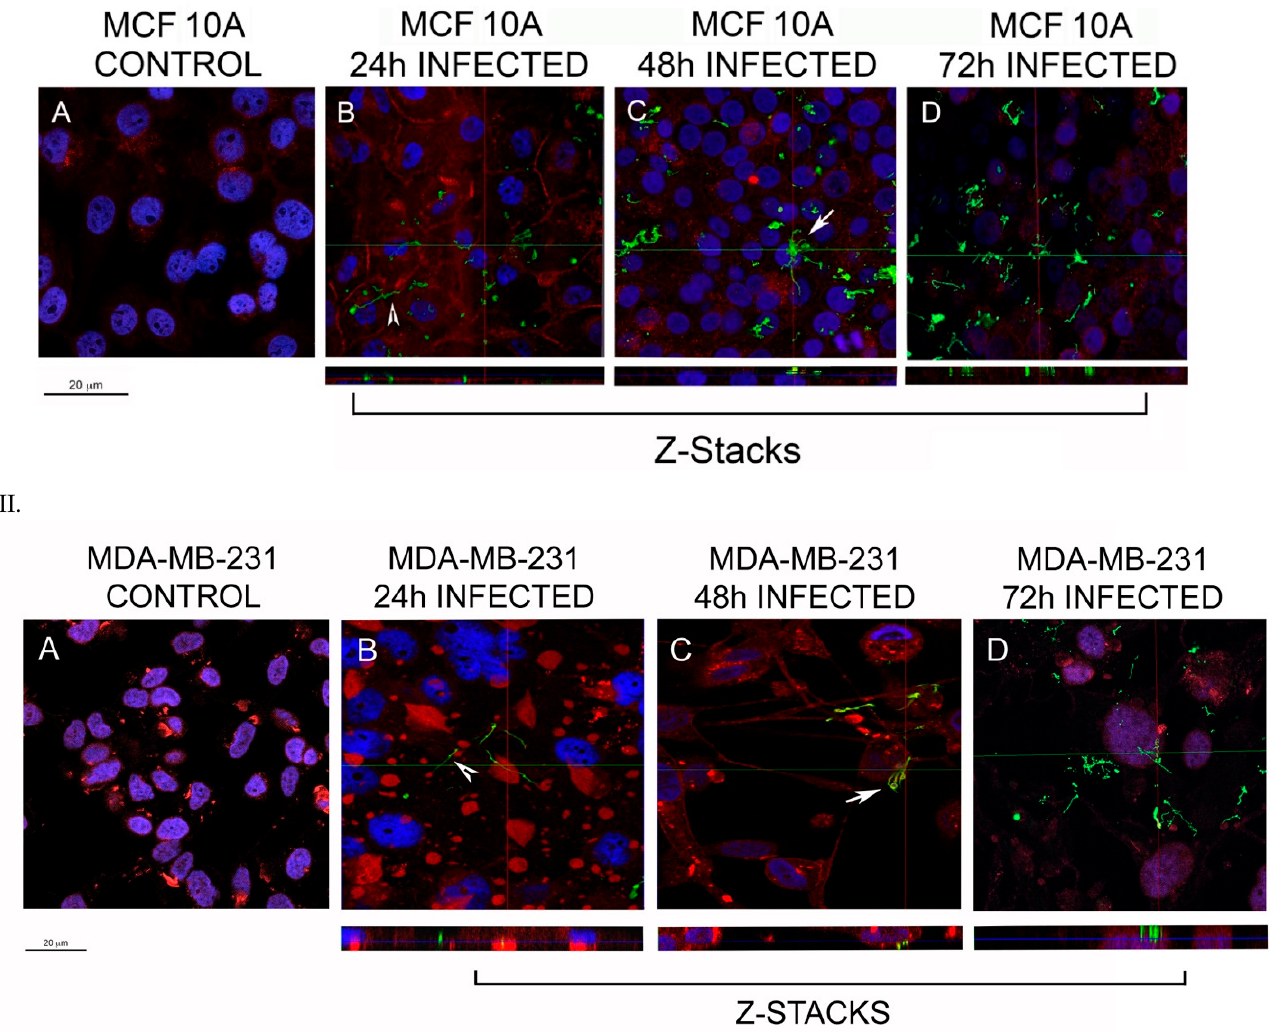
Figure 1. Representative confocal microscopy images of MCF 10A (Panel I) and MDA-MB-231 (Panel II) mammalian epithelial cells infected with B. burgdorferi . The cells were co-cultured with B. burgdorferi for ( B ) 24 h, ( C ) 48 h, and ( D ) 72 h. ( A ) Uninfected cells treated only with co-culture media were used as a control. CM-Dil membrane stain was used to label the cells (red), DAPI was used to stain the nucleus (blue) and polyclonal anti- B. burgdorferi was used to visualize B. burgdorferi cells (green), as described in the Material and Methods. The representative images were taken at 630X with a scale bar of 20 µ m. White arrowhead represents an invading spirochete and white arrow shows small B. burgdorferi aggregates inside the